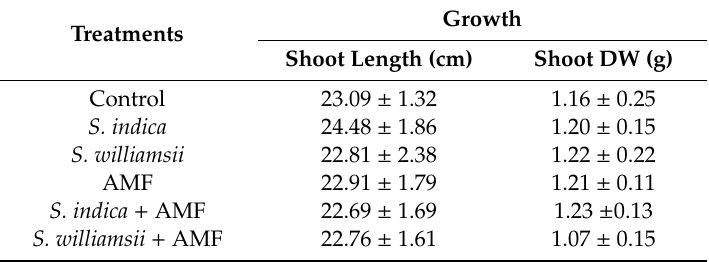
Table3. Meanvalues( ± S.D.)oftheabovegroundgrowthoftomatoplantsnineweeksaftertransplanting ( n =